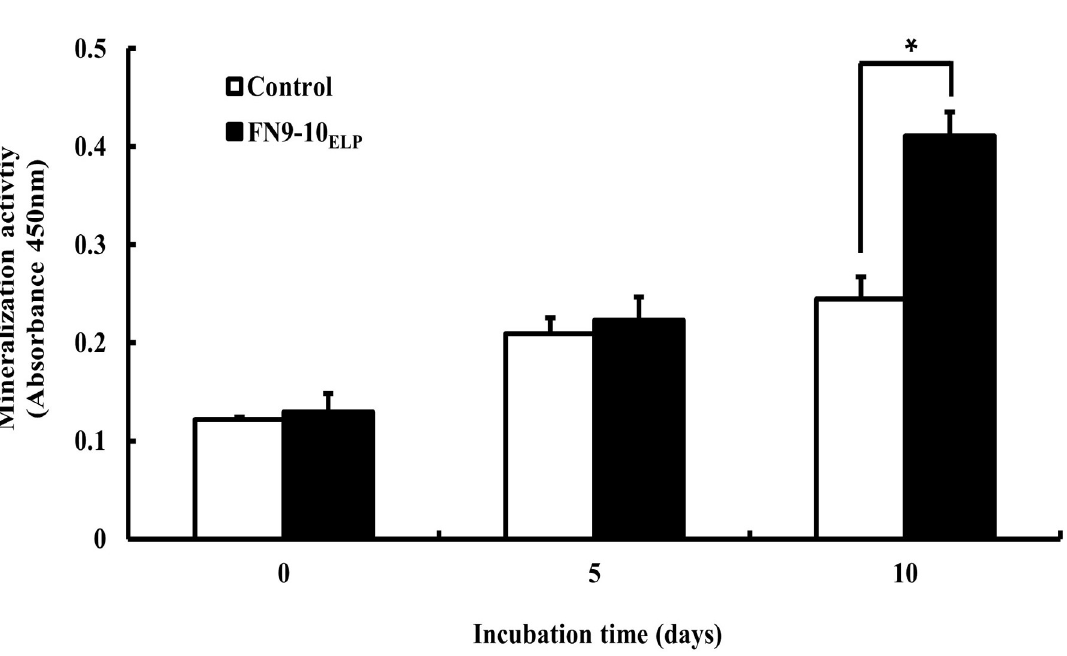
Fig 7. Mineralization activity of hMSCs on the FN9-10 ELP -titanium discs for 0, 5 and 10 days. The titanium discs were immersed in 10 μ g � mL − 1 FN9-10 ELP overnight at 4˚C, while the non-coated discs served as the control. The hMSCs were seeded at a density of 5 × 10 3 cells/disc and incubated for 0, 5 and 10 days at 37˚C. The mineralization activities are reported as the mean ± SD (n = 3). p < 0.05.